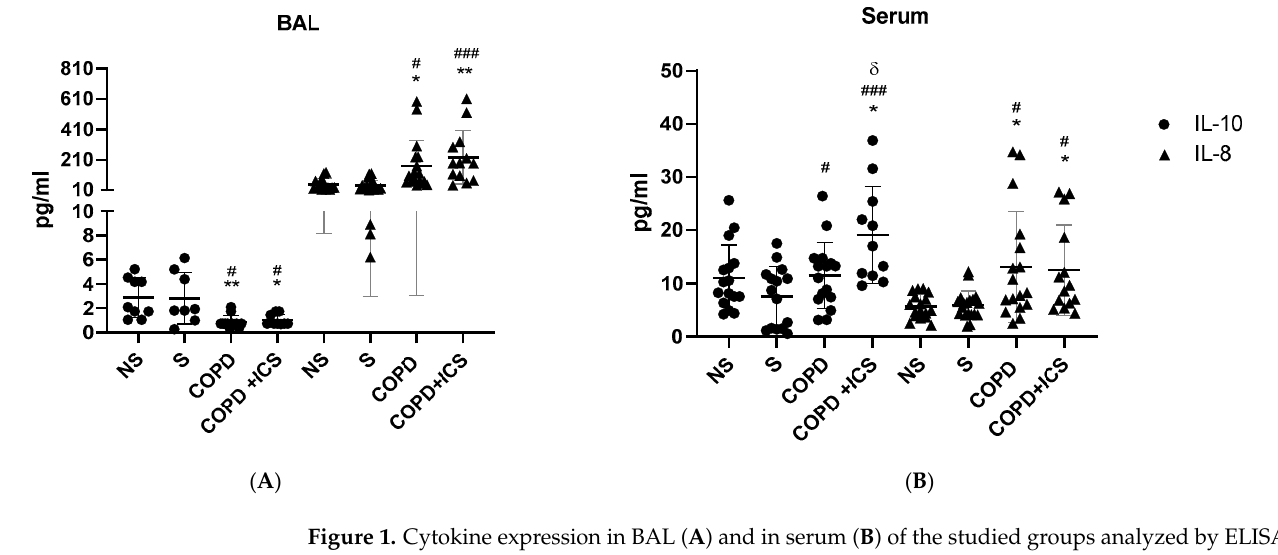
Figure 1. Cytokine expression in BAL ( A ) and in serum ( B ) of the studied groups analyzed by ELISA: NS, nonsmoker; COPD, chronic obstructive pulmonary disease without ICS baseline treatment; COPD + ICS, chronic obstructive pulmonary disease with inhaled corticosteroids use; IL, interleukin. * p < 0.05 and ** p < 0.01 vs. NS; # p < 0.05, and ### p < 0.005 vs. S; δ p < 0.05 vs. COPD. ● IL-10; ▲ IL-8